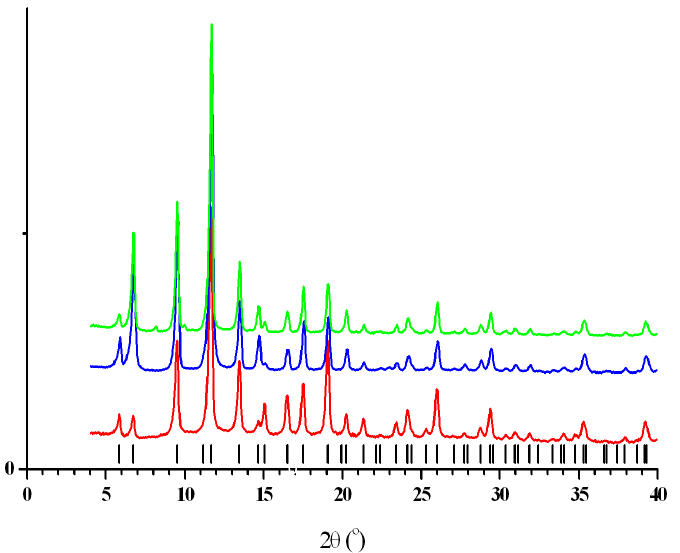
Figure 1. The combined presentation of the XRD patterns of the 5mw (red), 7mw (blue) and 8solv (green) samples. The vertical black bars show the calculated peak positions of the cubic HKUST-1 phase.